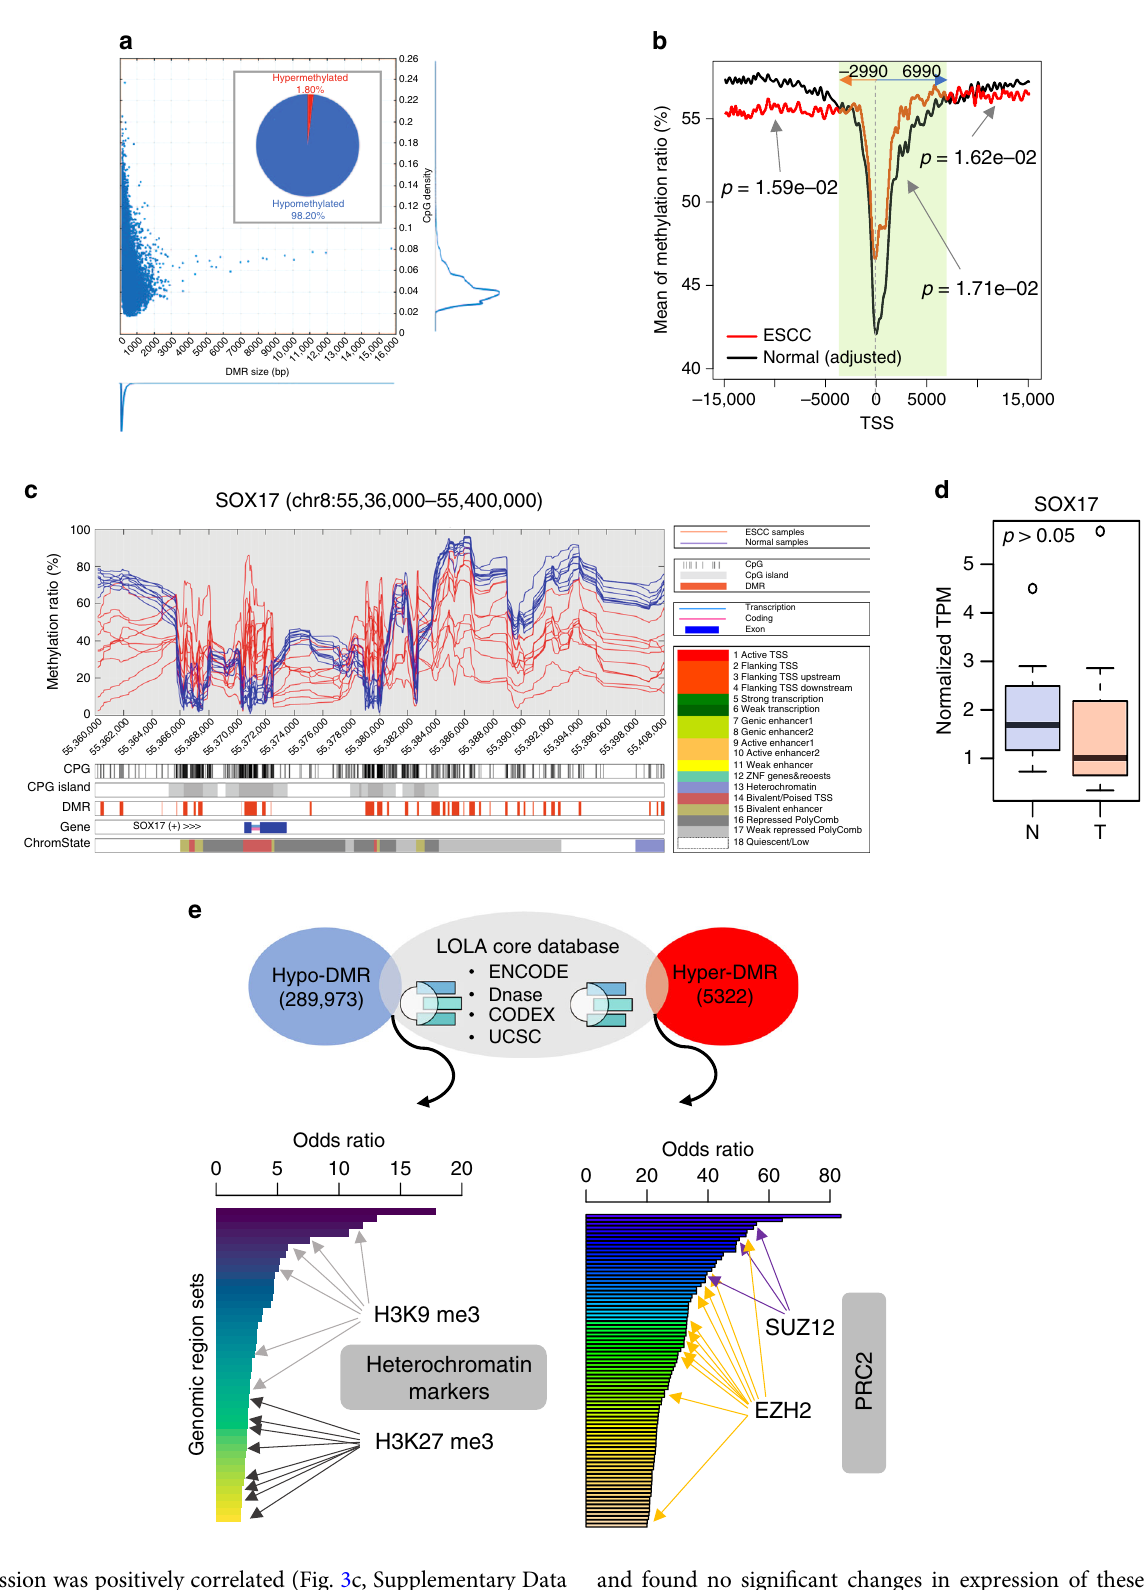
and found no signi fi cant changes in expression of these TFs in tumors versus normal samples (Supplementary Fig. 16). There- fore, the majority (98.5%) of these dysregulated genes in cluster C1 – C4 appear to occur via epigenetic dysregulation (epimuta- tion) 26 . This phenomenon was recapitulated in the independent TCGA-ESCC ( n = 96) sample cohort with available multi-OMICs datasets (Supplementary Fig. 17a –